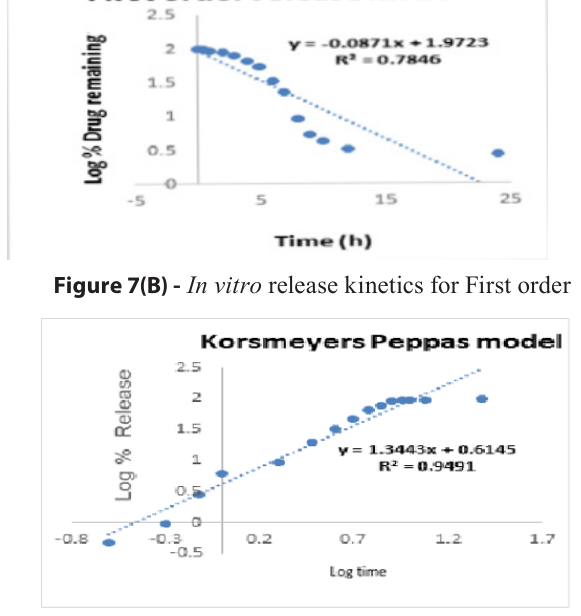
Figure 7(C ) - In vitro release kinetics for Higuchi model. Figure 7(D) - In vitro release kinetics for Higuchi